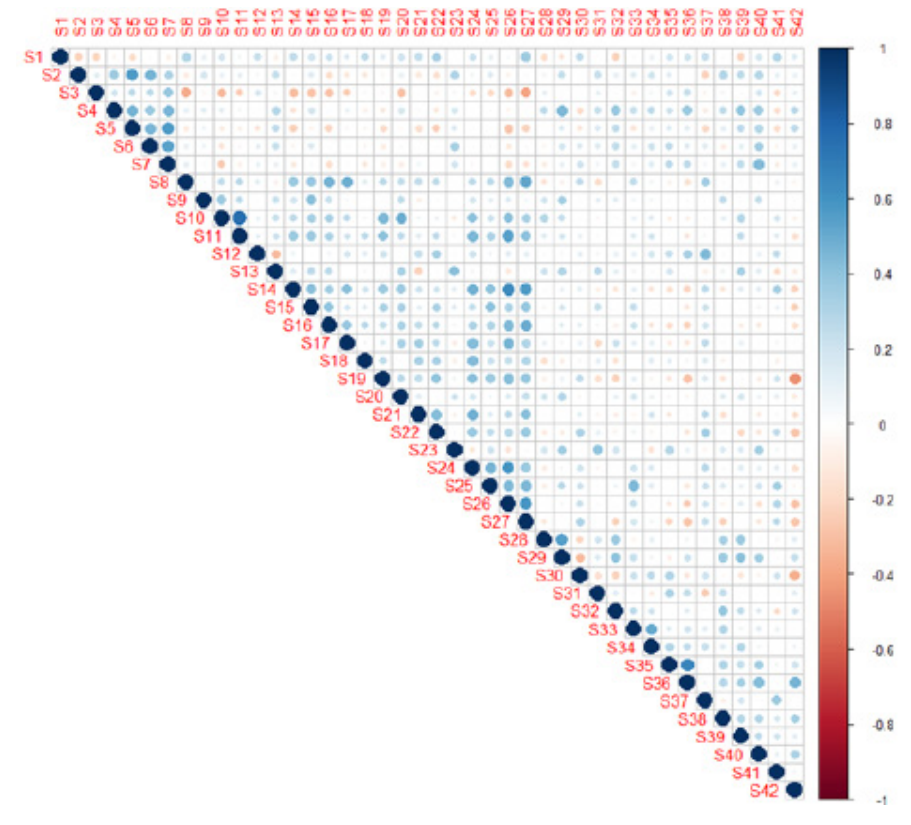
Figure 2. The SOHP item contribution matrix.